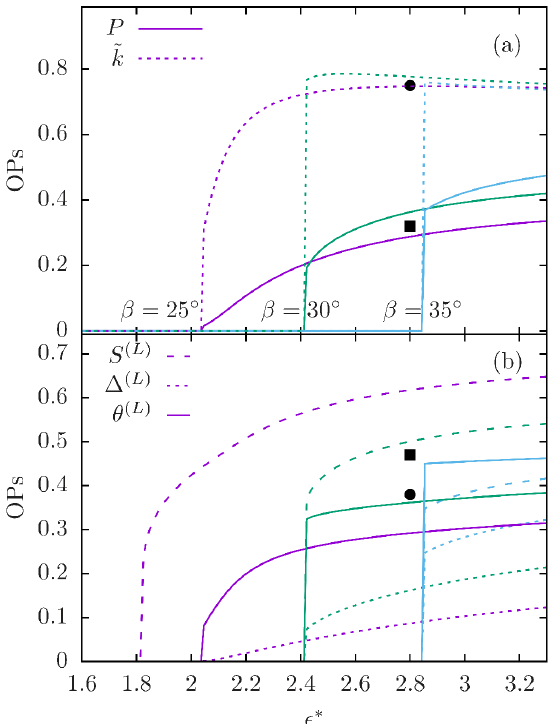
Figure 5. Representative diagrams of molecular theory results for the parameters characterizing the modulated ordering in the N PT phase as a function of the dimensionless inverse-temperature parameter ε ∗ ( ∼ 1/ T ) for three different values of the “bend-angle” β (see Figure 4b) and the torsion angle α held at α = 0. The phase sequence for β = 25 ◦ is I → N U → N PT , with decreasing temperature; for the values β = 30 ◦ ,35 ◦ the sequence is I → N PT . ( a ) Plots of the modulation wavenumber k scaled over the molecular size d ( (cid:101) k ≡ kd ) and of the polar order parameter P = (cid:104) y · m (cid:105) , measuring the degree of polar alignment of the C 2 molecular axis y along the local polar director m . The points indicated by solid symbols are MD results [17] for (cid:101) k (circle) and P (square) calculated at T = 0.965 T N − N . ( b ) Plots of (i) the maximal principal value S ( L ) of the second rank ordering tensor of the mesogenic units, (ii) the difference ∆ ( L ) of the other two principal values (i.e., the biaxiality) of the tensor, (iii) of the angle θ ( L ) (in radians) by which the modulation axis Z is locally rotated about the director m to obtain diagonalization of the ordering tensor (equivalently, angle formed between the modulation direction Z and the principal axis of the second rank ordering tensor of the mesogenic unit L ). As in ( a ), the points indicated by solid symbols are MD results [17] for S ( L ) (square) and θ ( L )